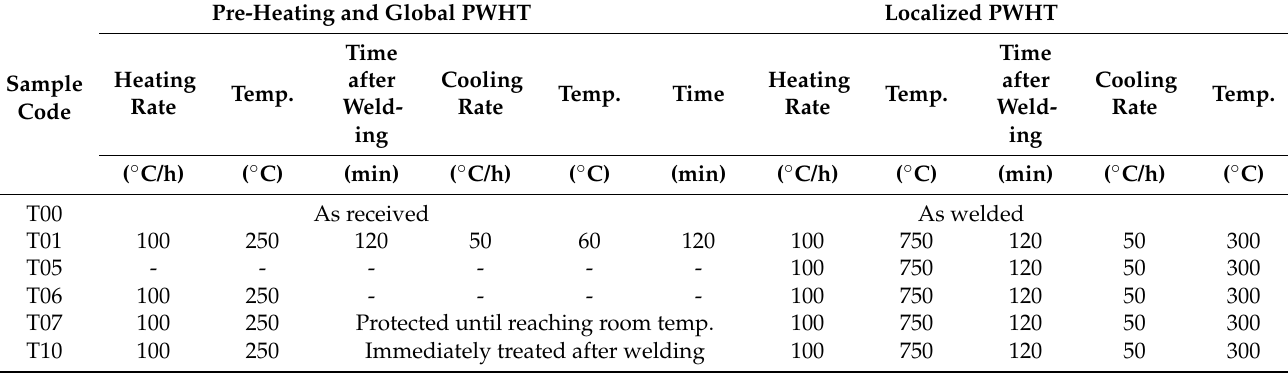
Table 5. Different thermal cycles applied to the various welded samples.